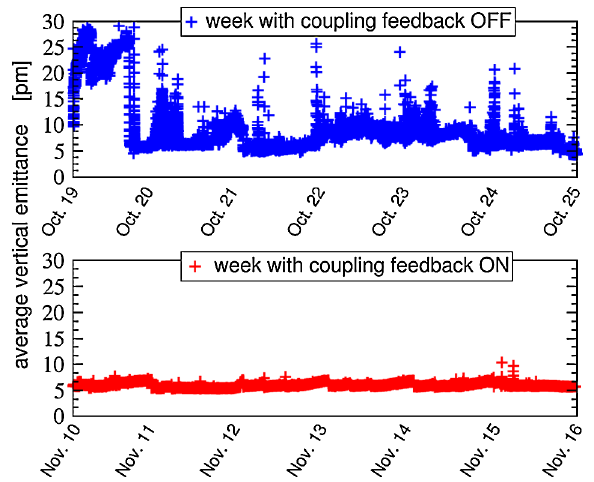
FIG. 10. Comparison between the mean vertical apparent emit- measured during beam delivery without (top) and with tance (cid:2) (cid:3) y (bottom) the coupling feedback. Data acquired during injections are not